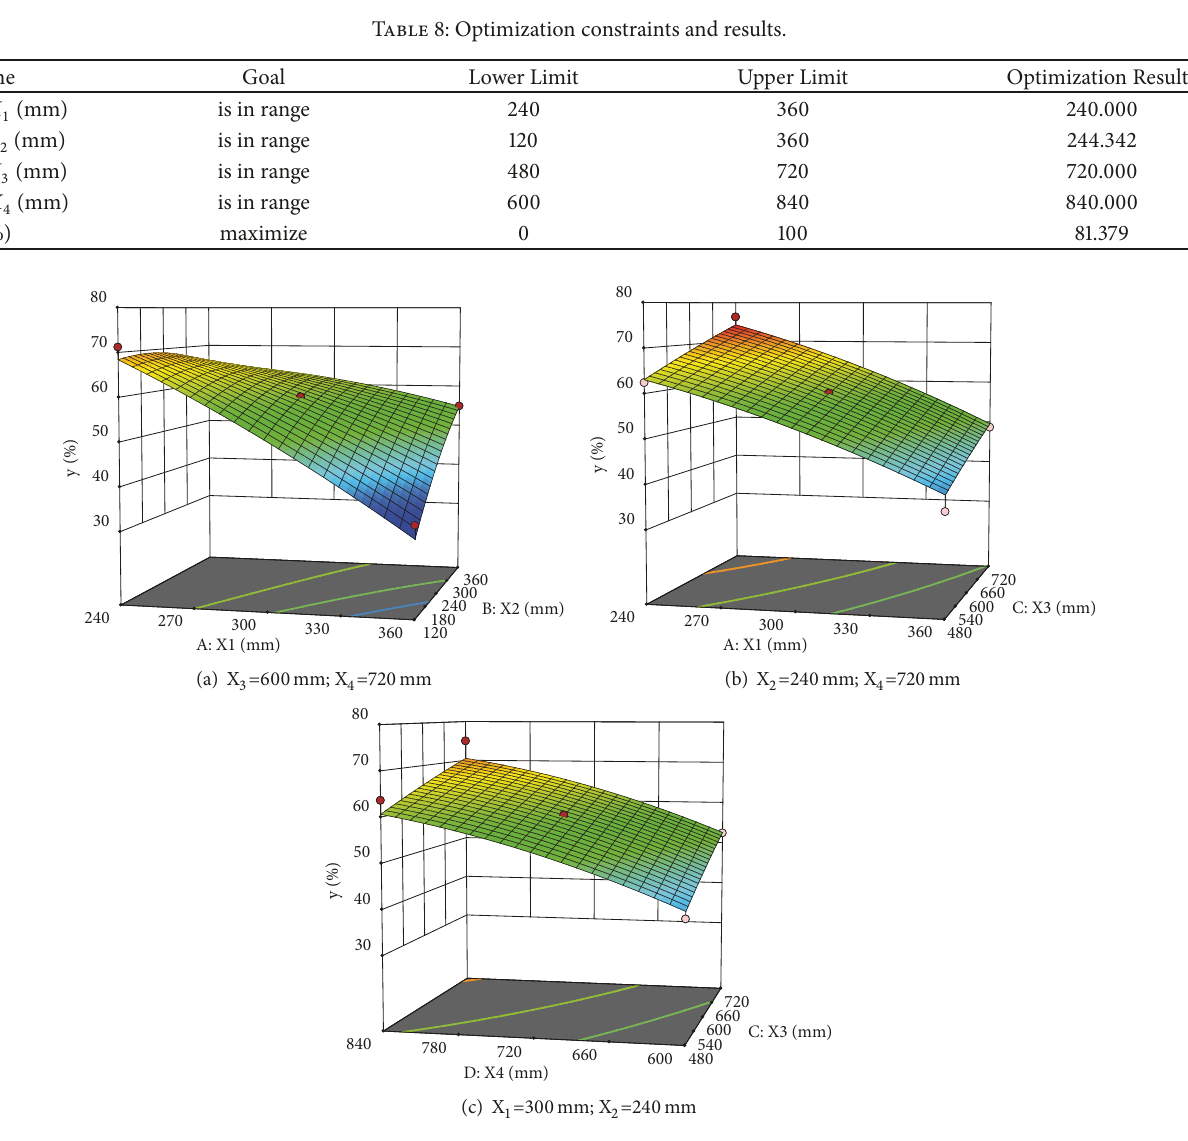
Figure 5: Effect of different factors on separation efficiency.